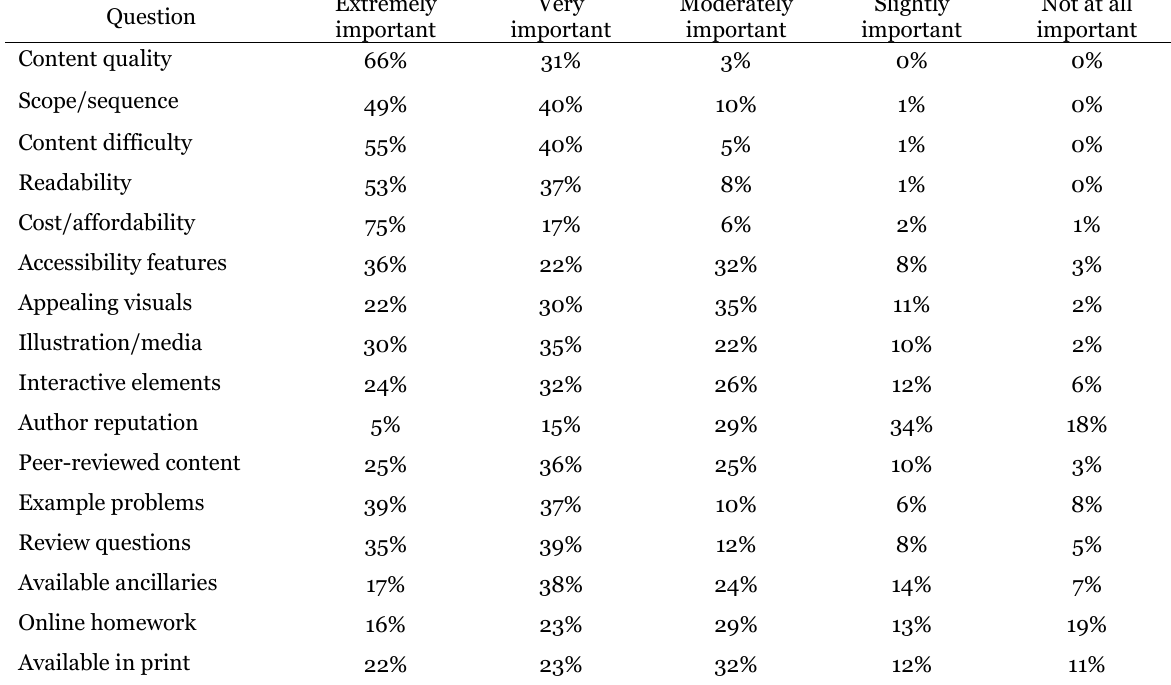
Table 3 Characteristics of Open Textbook